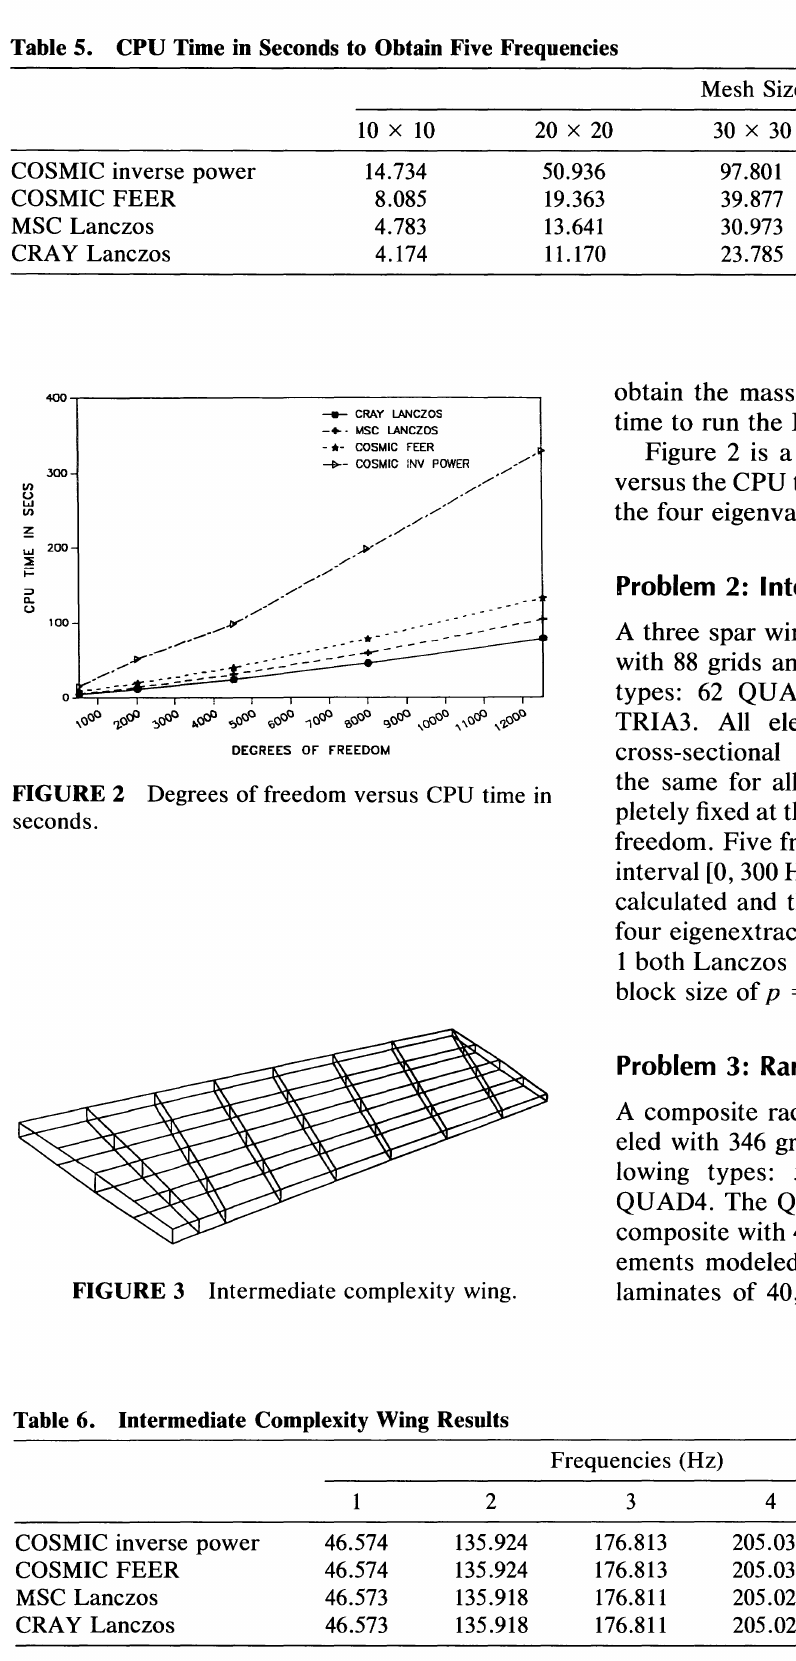
Table 5. CPU Time in Seconds to Obtain Five Frequencies